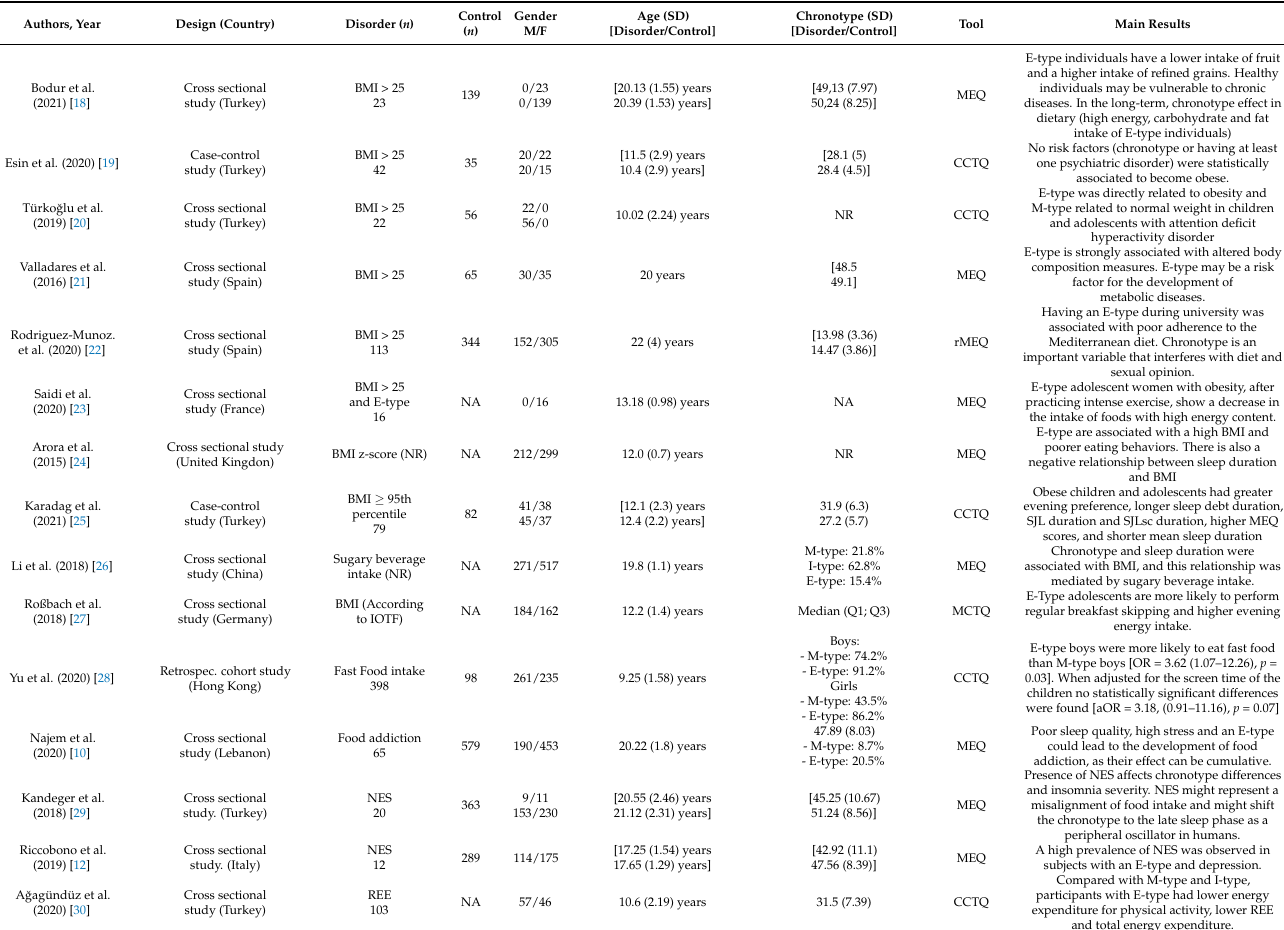
Table 1. Main characteristics of the selected